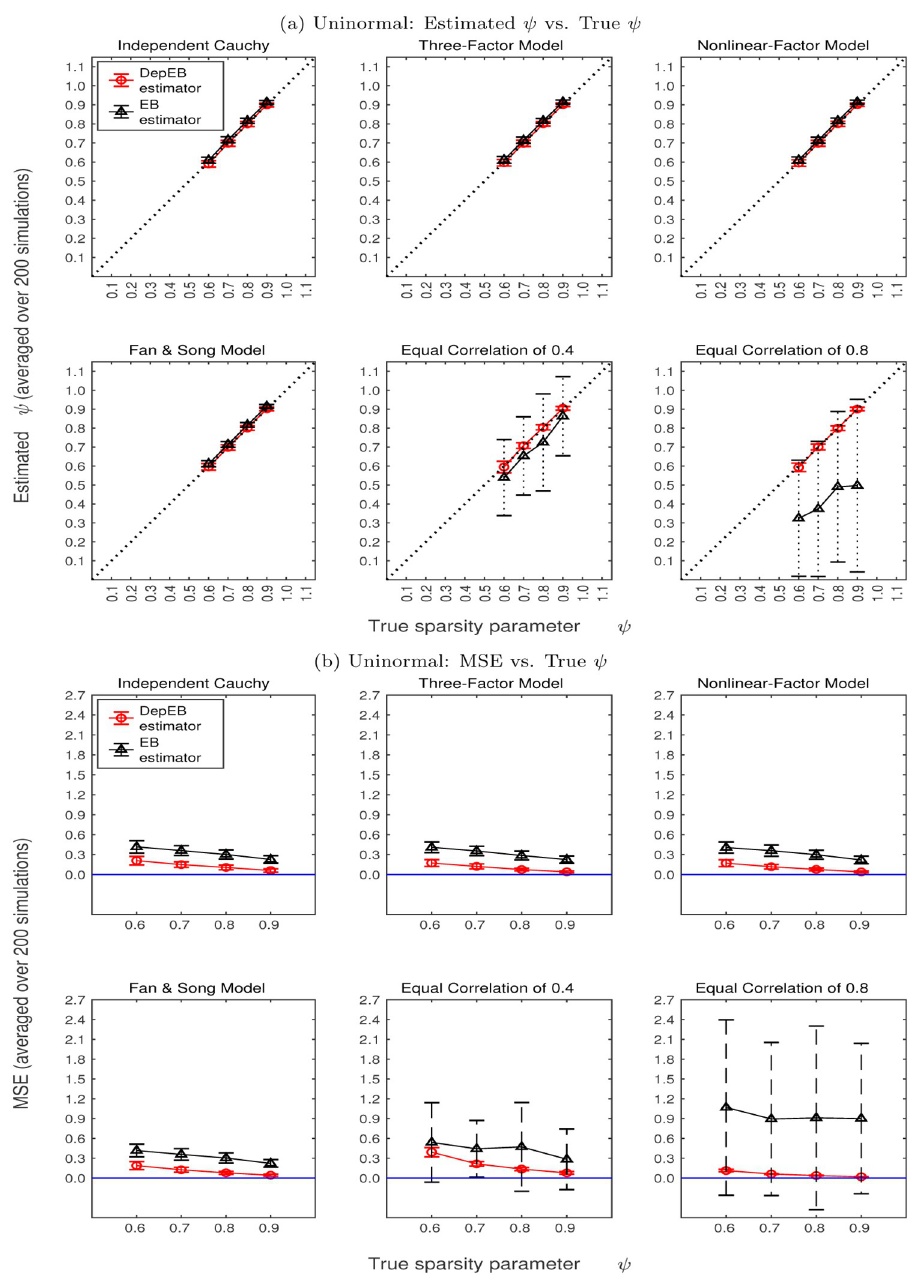
Fig 2. Estimated ψ and MSE for uninormal type of X and six covariance structures of error terms Z . deviation of estimated ψ , standard deviations of MSEs in our proposed DepEB algorithm are small for different types of correlation structure in the error terms, while the standard devia- tions of MSEs estimated by the EB algorithm are large when there are moderate to strong cor- relations in the error terms (e.g. Equal Correlation of 0.4 and 0.8 models); 4) As the signal becomes more sparse, the standard deviations of MSEs estimated by both the DepEB algo- rithm and EB algorithm generally become smaller.